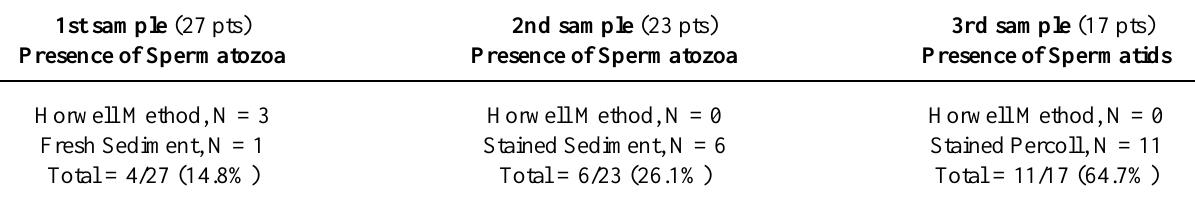
Table 2 – Summary of laboratory results from patients under study.